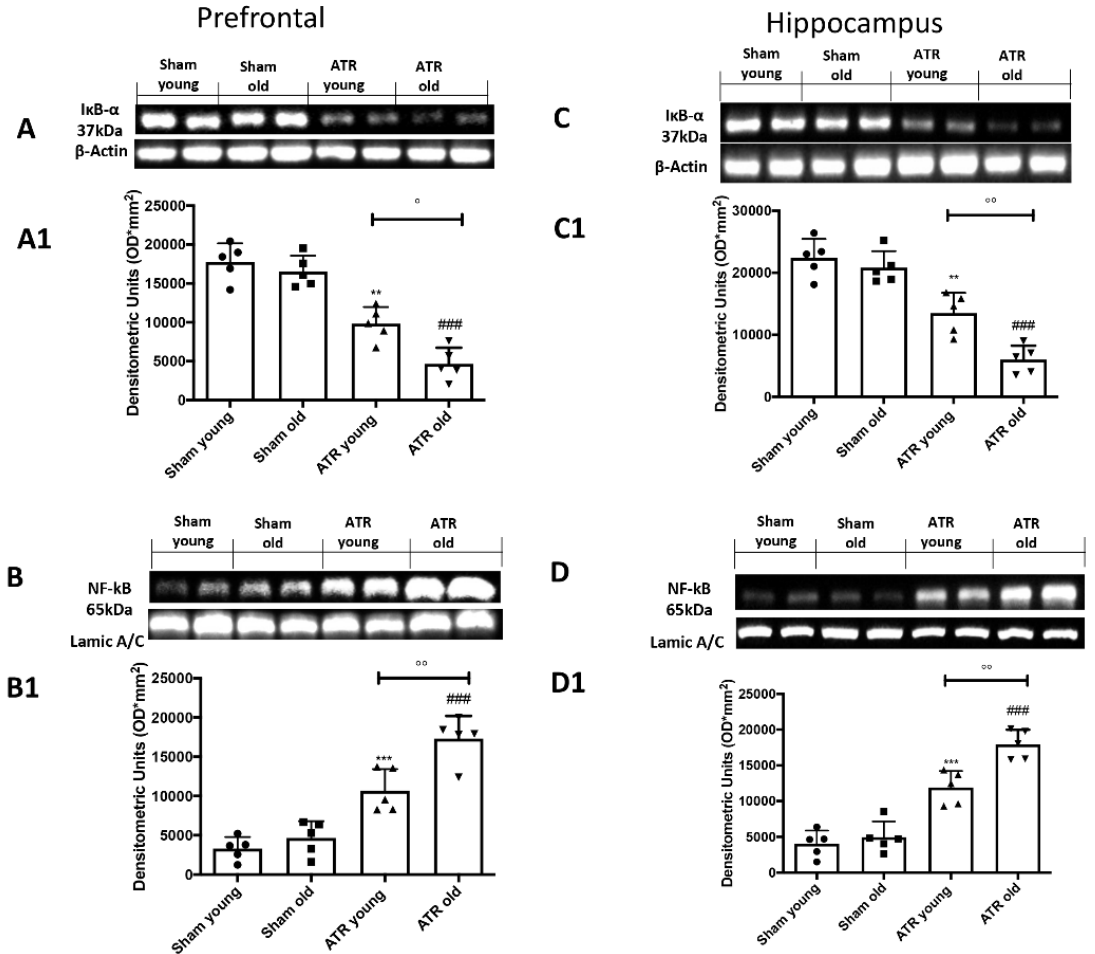
Figure 8. Impact of ATR inhalation on brain inflammation. Western blots and respectively quantification of ik-b α in prefrontal cortex ( A , A1 ) and hippocampus ( C , C1 ) and nf-kb in prefrontal cortex ( B , B1 ) and hippocampus ( D , D1 ). We found that aged mice are more subjected to brain inflammation compared to young mice after 28 days of ATR inhalation. Data is expressed as the mean ± SEM of n = 5 animals for each group. * p < 0.05 vs. Sham young; ** p < 0.01 vs. Sham young; *** p < 0.001 vs. Sham young; ### p < 0.001 vs. Sham old; ° p < 0.05 ATR old vs. ATR young; °° p < 0.01 ATR old vs. ATR young.